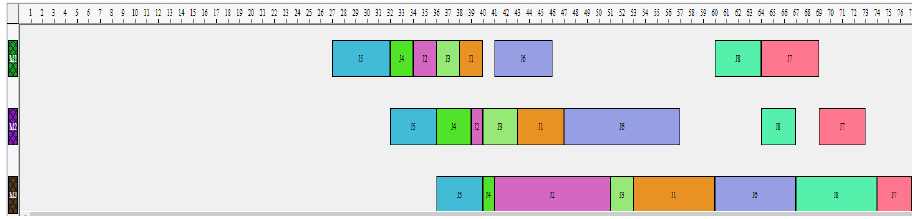
Figure 8. Gantt chart of the best solution with eight jobs by ACO.